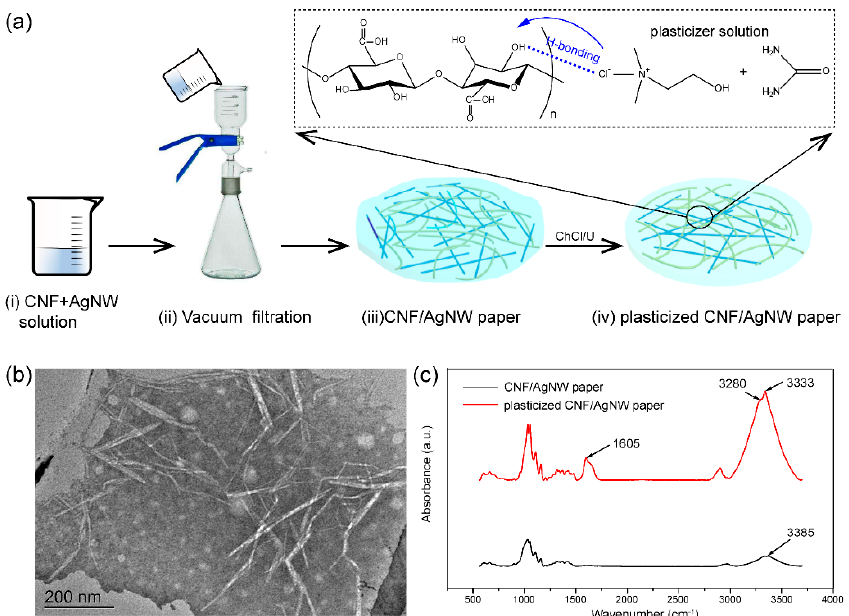
Figure 1. Fabrication process and characterization of plasticized conductive paper. ( a ) Preparing conductive paper includes: (i) mixing the CNFs with AgNWs thoroughly; (ii) vacuum filtration of CNF/AgNW mixed solution; (iii) the CNF/AgNW hybrid gels; and (iv) the plasticized transparent, flexible, conductive CNF/AgNW paper. ( b ) TEM image of CNF. ( c ) FTIR spectra of CNF/AgNW paper